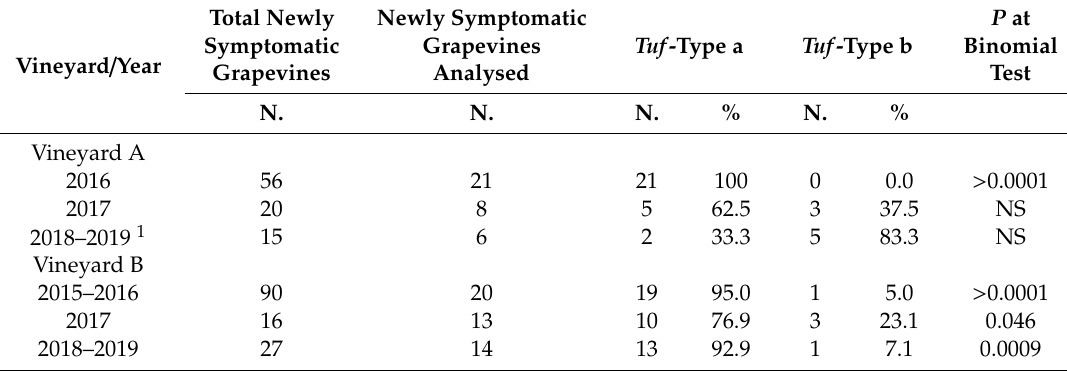
Table 4. “ Ca . P. solani” tuf -type identified on GY symptomatic grapevines in vineyards A and B. Newly Symptomatic Total Newly Symptomatic Vineyard / Year Grapevines